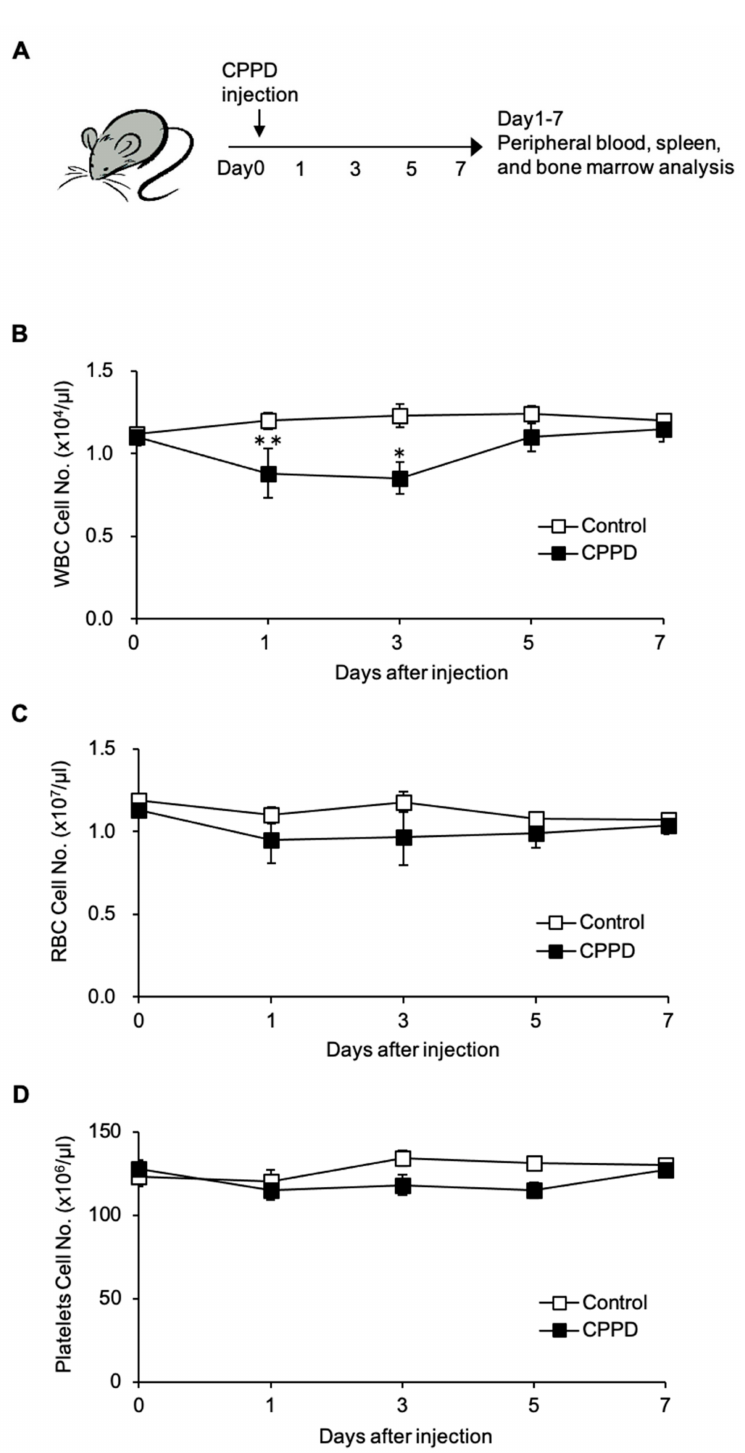
Figure 1. Calcium pyrophosphate dihydrate (CPPD) injection induces reduction of white blood cells (WBCs) in the peripheral blood. ( A ) Experimental design for in vivo injection of CPPD. ( B – D ) The time course of cell number of WBCs ( B ), red blood cells (RBCs) ( C ), and platelets in the peripheral blood (PB) ( D ) were analyzed after vehicle (PBS) or CPPD (100 µ g) injection. Data represent the mean ± s.d. of three independent experiments. * p < 0.01, ** p <